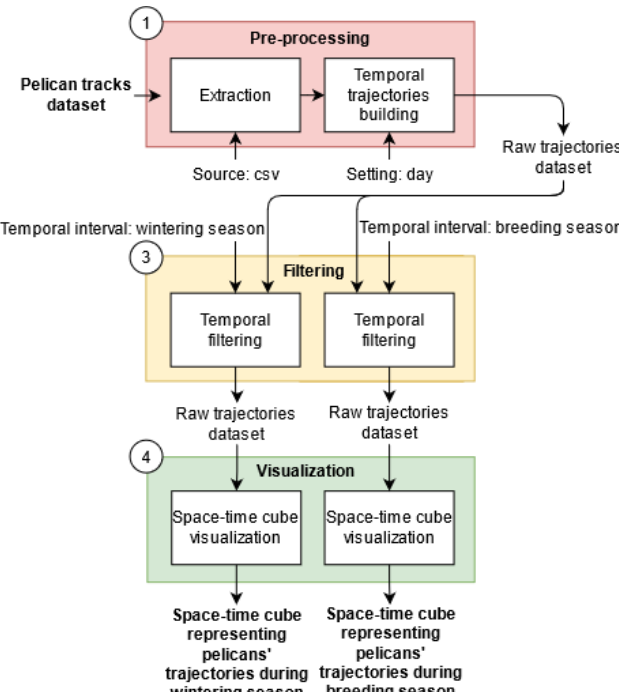
Figure 12. Customized processing chain to answer question (4).